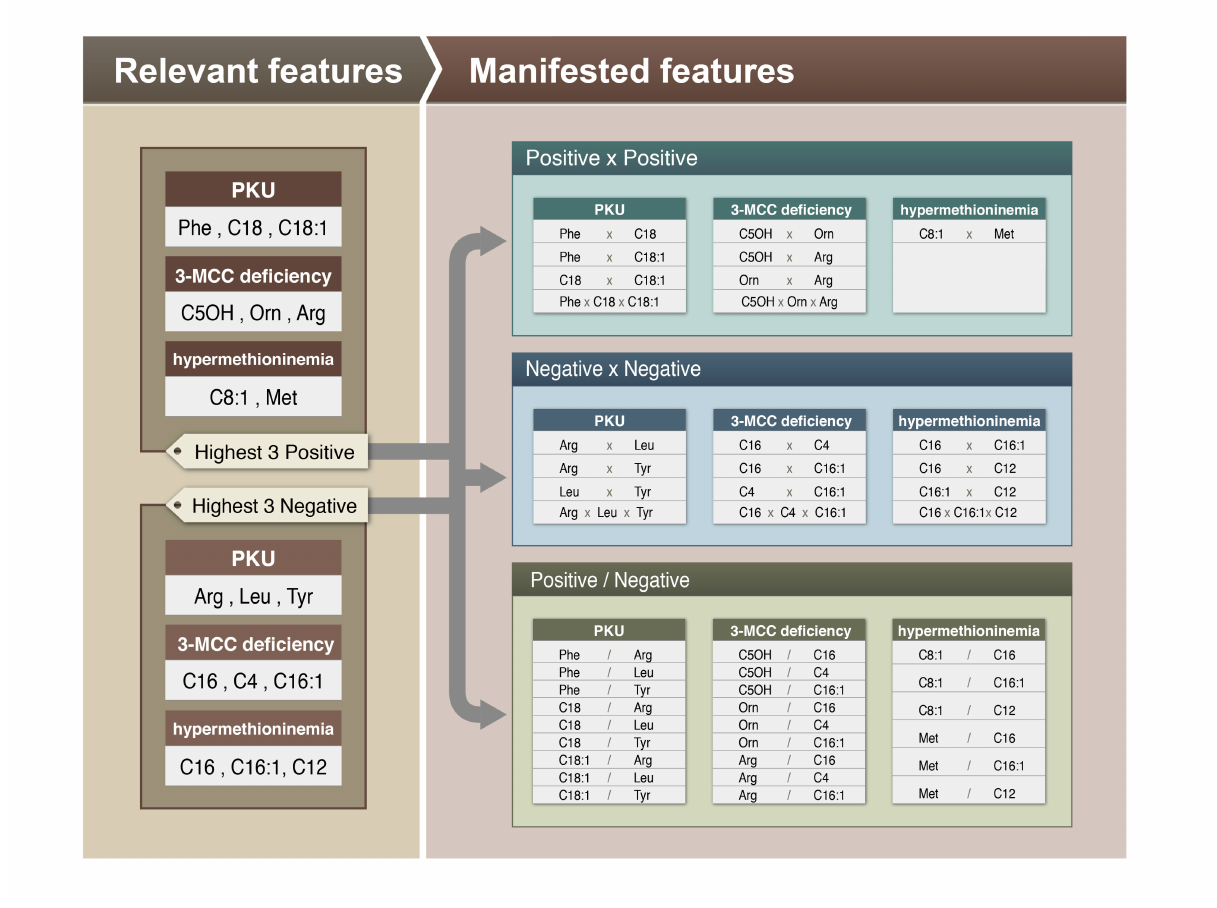
Figure 6. Feature selection strategies by relevant